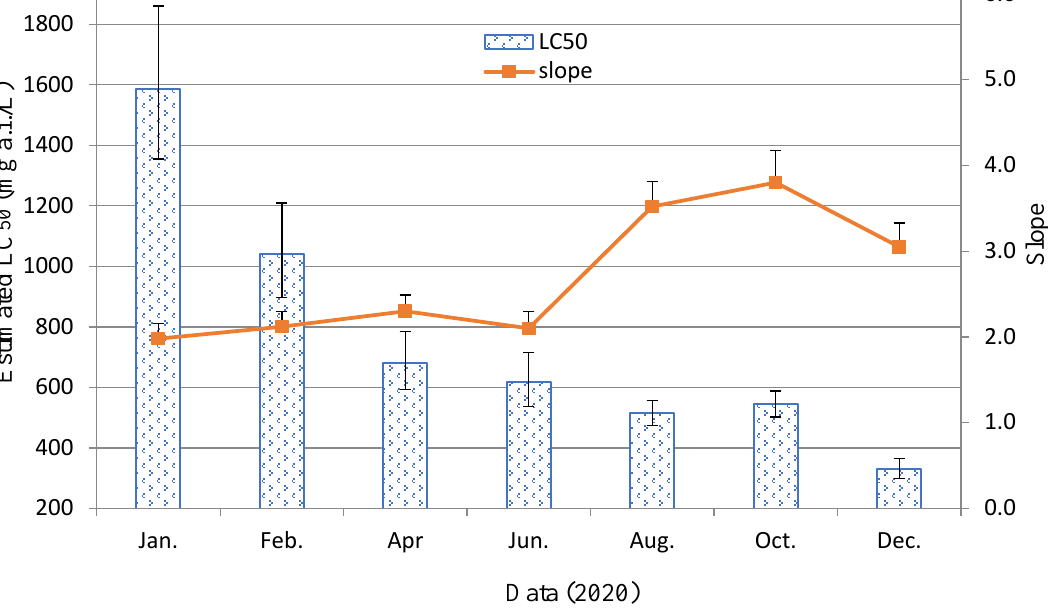
Figure 2. Stability of spirotetramat resistance in ST-NK mites kept on unsprayed citrus plants (starting